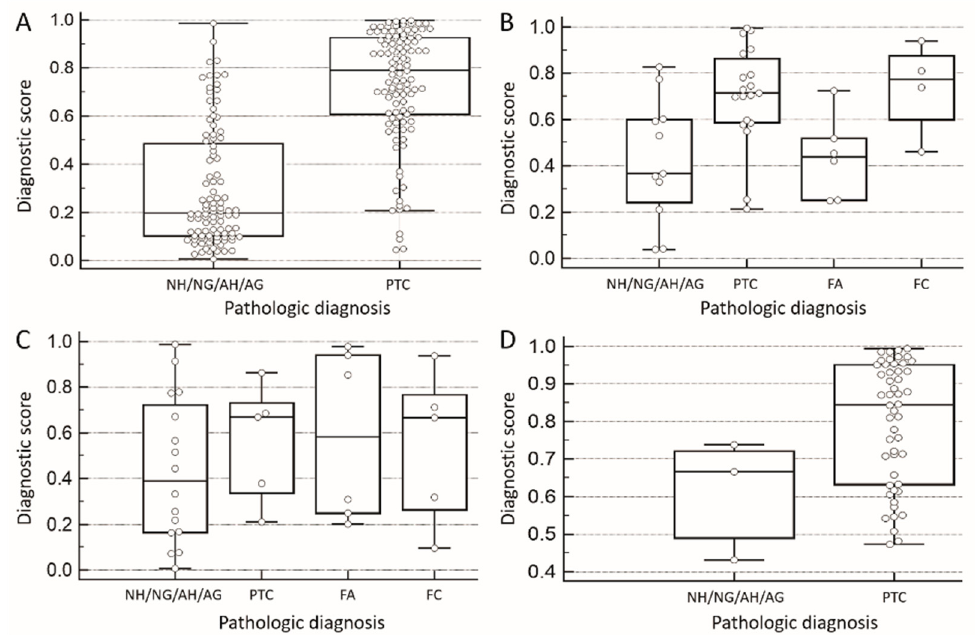
Figure 2. Box plots of the relationship between a diagnostic score and pathologic diagnosis. ( A ) In pathologic diagnosis of papillary thyroid cancer and benign follicular lesions other than follicular adenoma ( n = 210). ( B ) In Bethesda cytological category of atypia of undetermined significance or follicular lesion of undetermined significance ( n = 40). ( C ) In Bethesda cytological category of follicular neoplasm or suspicious for a follicular neoplasm ( n = 32). ( D ) In Bethesda cytological category of suspicions for malignancy ( n = 53). NH: Nodular hyperplasia. NG: Nodular goiter. AH: Adenomatous hyperplasia. AG: Adenomatous goiter. PTC: Papillary thyroid cancer. FA: Follicular adenoma. FC: Follicular